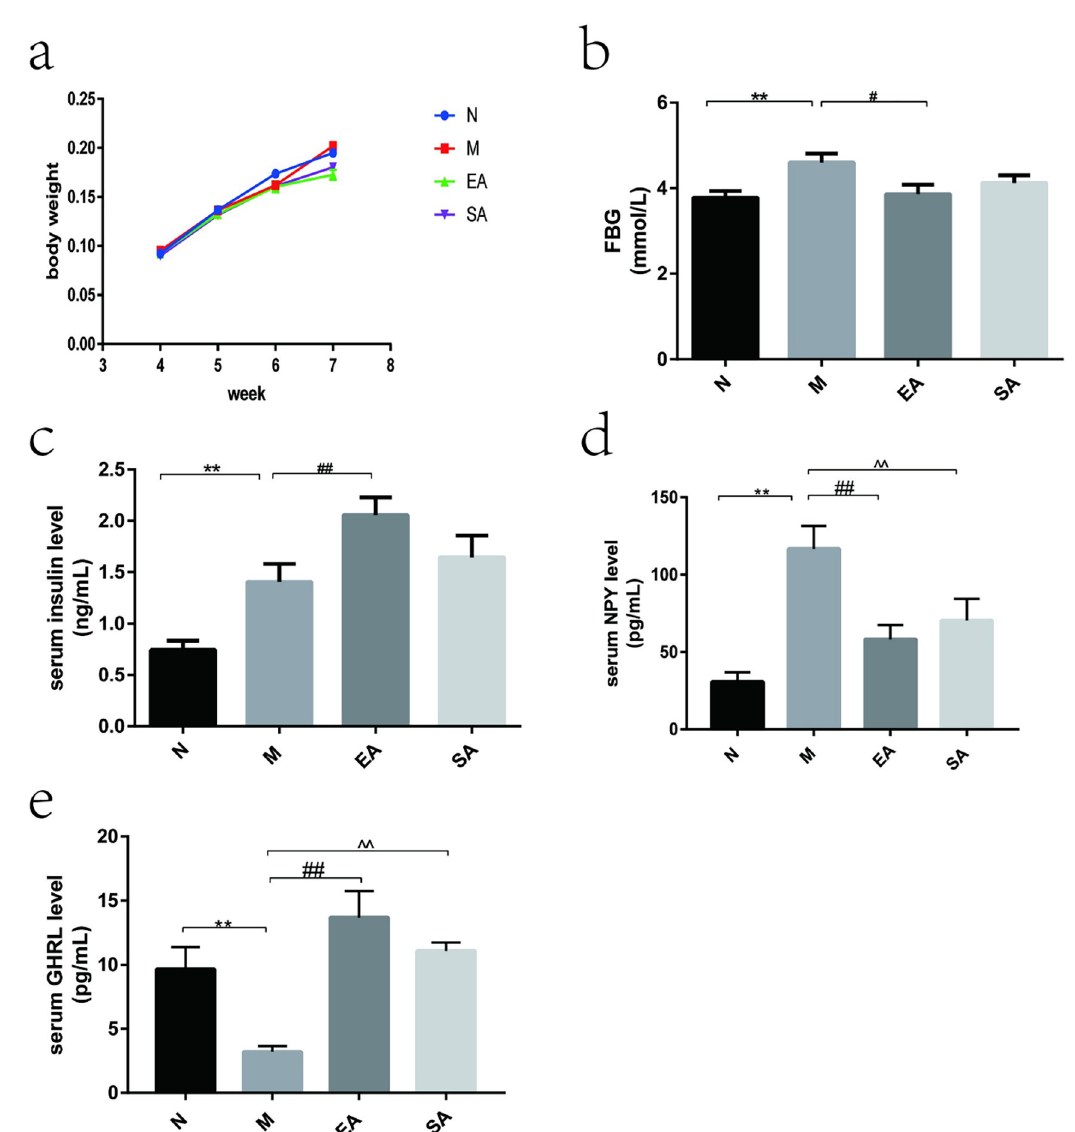
Fig 3. Changes of body weight and serum levels of metabolic indicators. a: body weight; b: FBG level; c: serum insulin level; d: serum NPY level; e: serum GHRL level; N, normal group; M, model group; EA, electroacupuncture group; SA, sham acupuncture group; FBG, fasting blood glucose; NPY, neuropeptide Y; GHRL, ghrelin; The values are shown as mean ± SEM. N vs M, � P < 0.05, �� P < 0.01; EA vs M, # P < 0.05, # # P < 0.01; SA vs M, ^ P < 0.05, ^ ^ P < 0.01. Eight rats per group were used in each